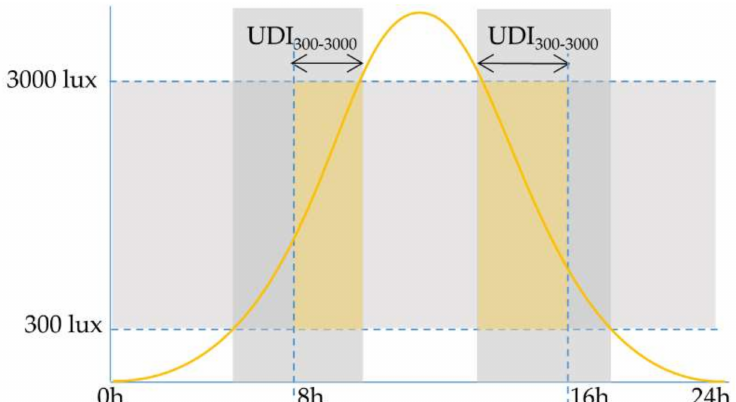
Figure 2. UDI represents the annual occurrence of daylight illuminances falling within the given range (gray-marked area); UDI 300–3000 used in this paper is limited to the range of 300–3000 lx with working hours